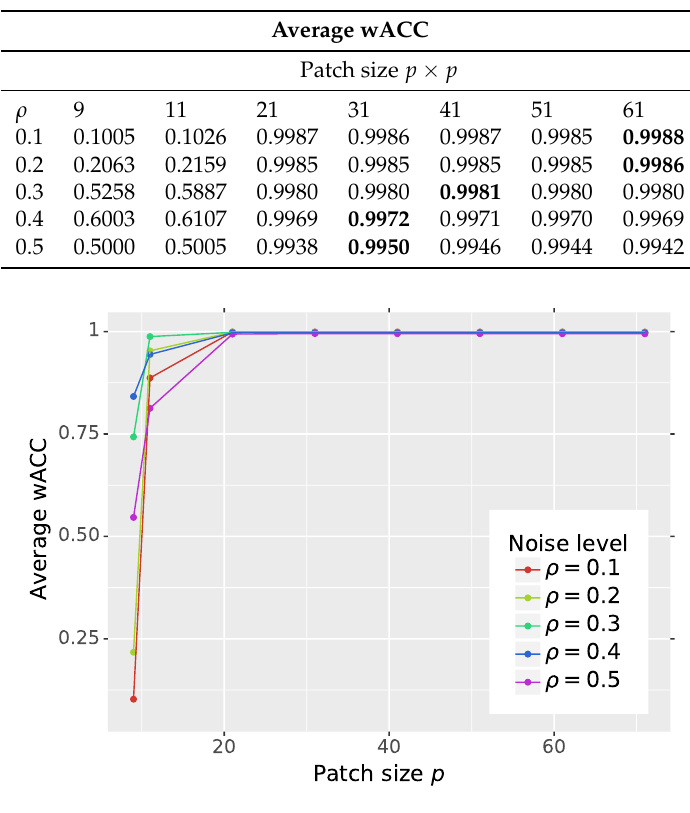
Table 3. Impact of the patch size used in the training procedure on the detection performance of the network in terms of wACC. The best values are presented in bold font.